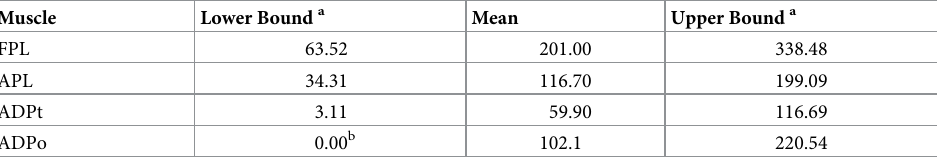
Table 1. Range of maximum isometric force values input into the lateral pinch model for each thumb muscle varied.